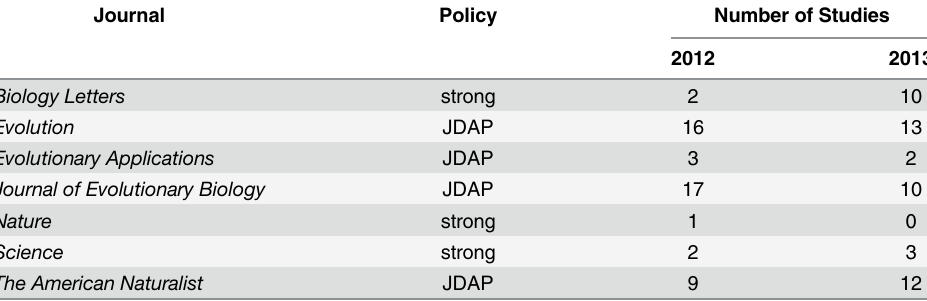
Table 1. Journal and publication year of 100 reviewed studies with associated data publicly archived in the digital repository Dryad (http://datadryad.org/). At the time of data deposition in the repository, jour- nals had either a “ strong ” PDA policy or adhered to the Joint Data Archiving Policy (JDAP), both of which require that data necessary to replicate a study ’ s results be archived in a public repository. Datasets were examined to assess completeness and